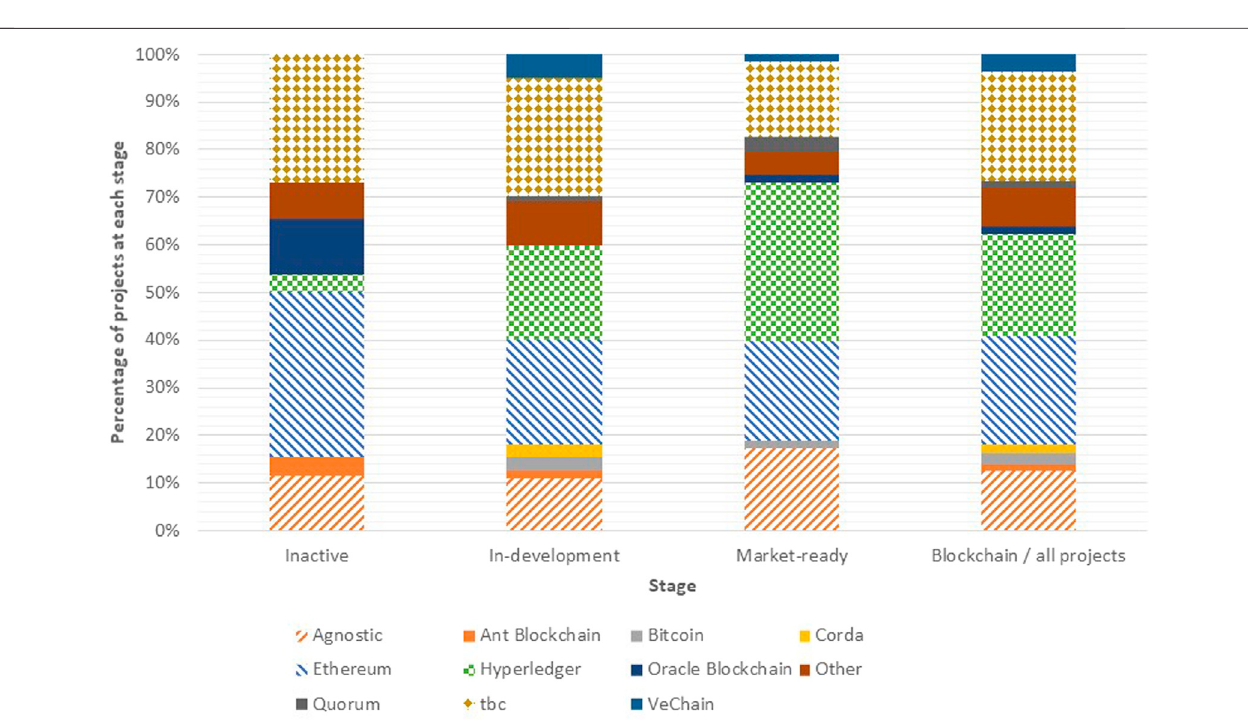
Frontiers in Blockchain |